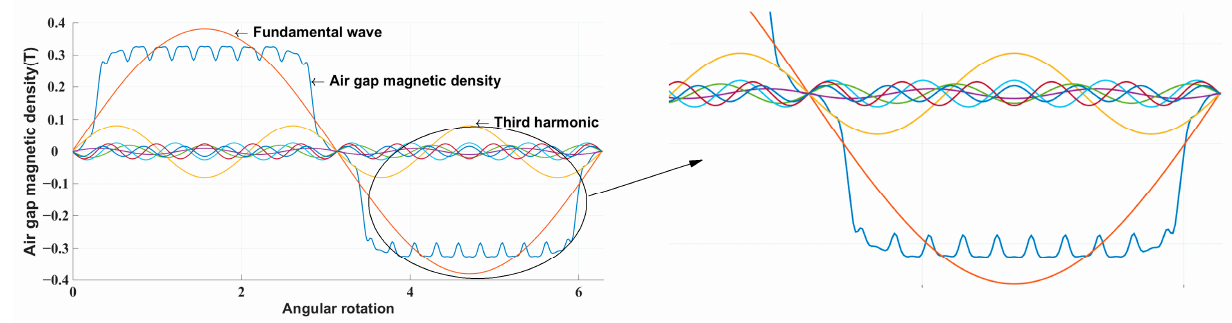
Figure 7. An analysis result of the air gap magnetic density harmonic in the no-load condition.